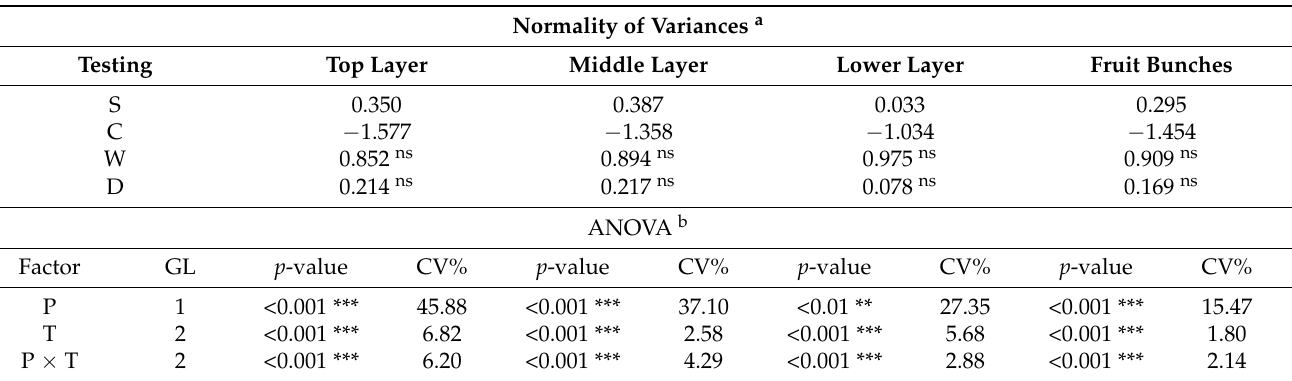
Table 5. Normality and analysis of variance (ANOVA) for droplet density at different plant layers and fruit clusters of papaya.